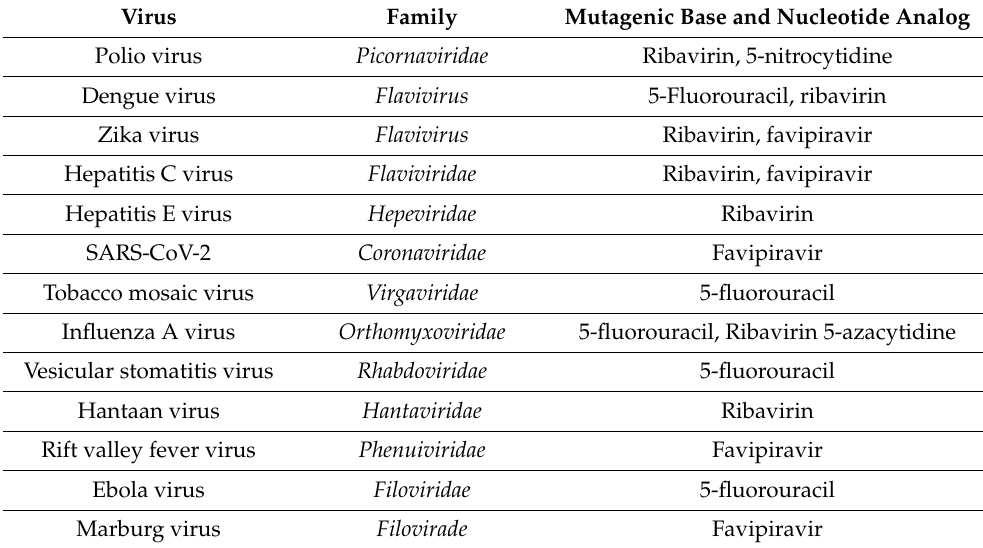
Table 1. A list of mutagenic base and nucleotide analogs used in lethal mutagenesis of RNA